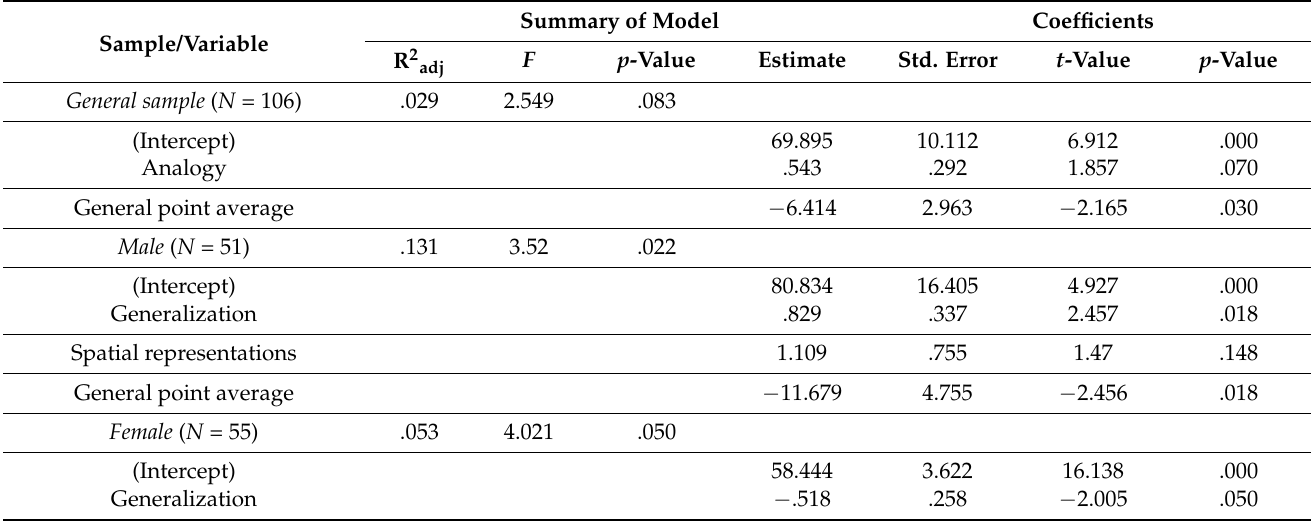
Table 6. Best predictor regression models for Ambivalence subscale of ISS.